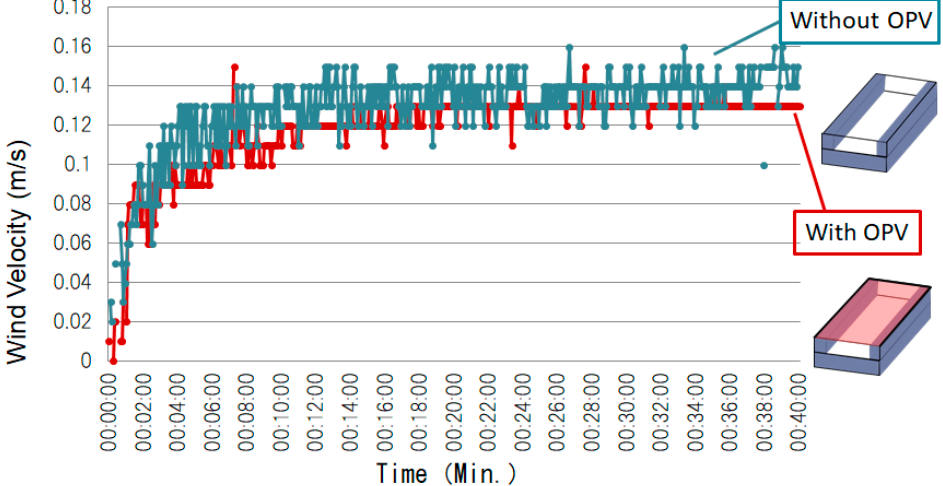
Figure 9. Velocity of generated wind in OPV-solar chimney with and with OPV sheet.